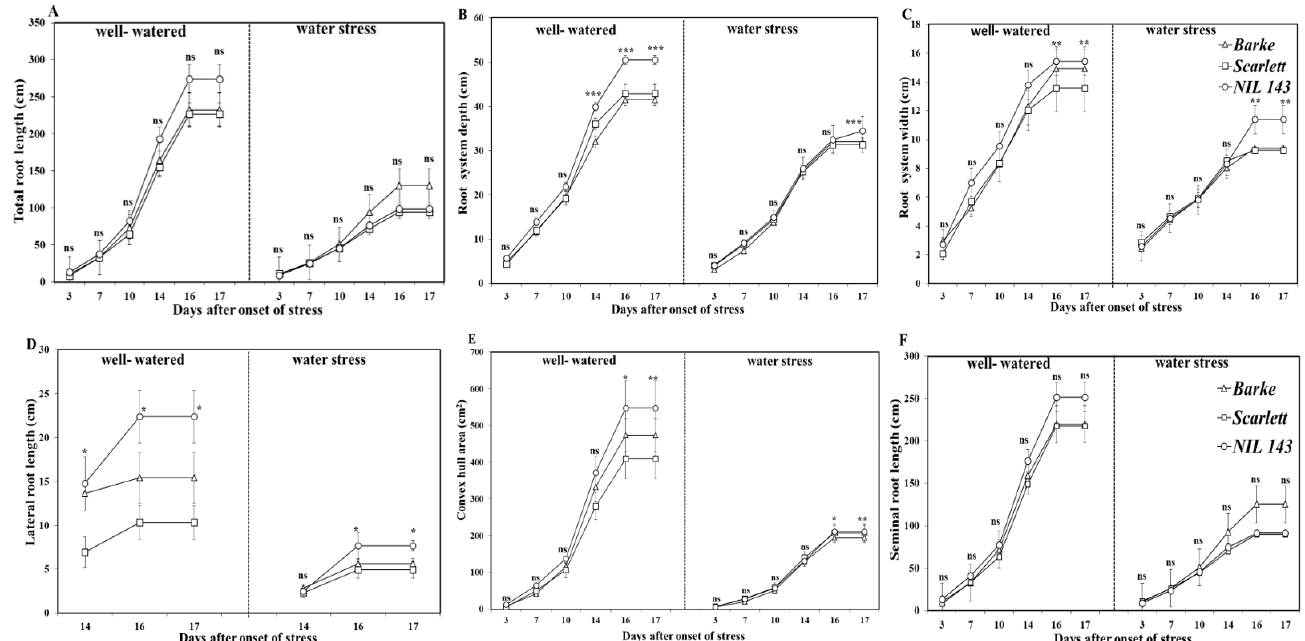
Figure 2. Visible root system growth at the seedling stage over time among the different barley genotypes under well- watered and water stress in rhizoboxes. Plotted are the means fitted with the standard error, n = 6. Significant differences ( α = 0.05) among genotypes and treatments at specific days after stress are indicated with asterisks *, **, ***, which follow the standard probability values of 0.05, 0.01, and 0.001, respectively. In the panel: ( A )—total root length; ( B )—root system depth; ( C )—root system width; ( D )—lateral root length; ( E )—convex hull area; and ( F )—seminal root length.